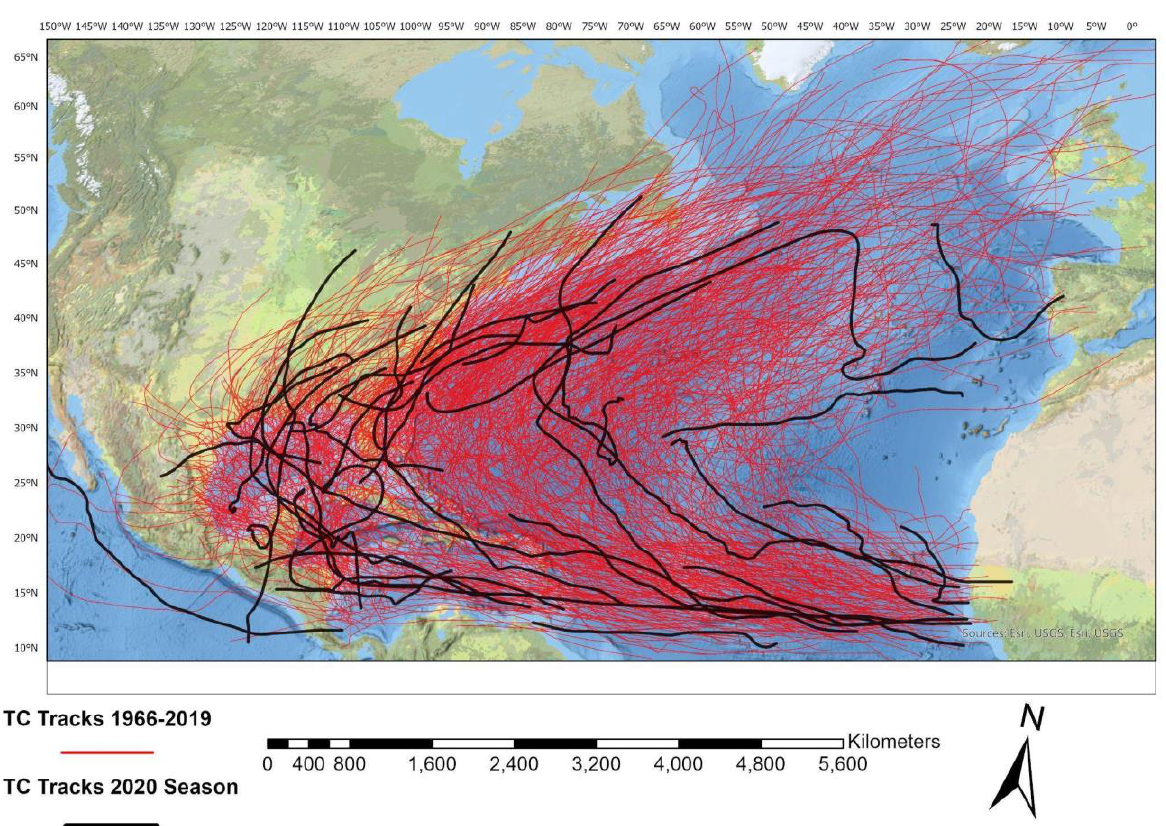
Figure 1. All tropical cyclones that formed in the North Atlantic basin from 1966 to 2020. The 2020 hurricane season tracks are highlighted in black.